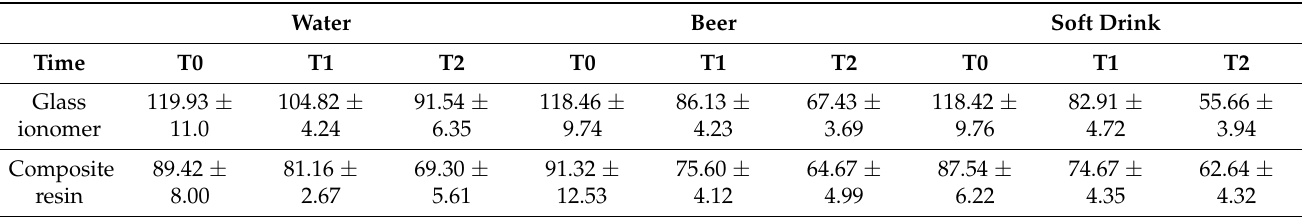
Table 4. Results regarding microhardness of glass ionomer and composite resin specimens.